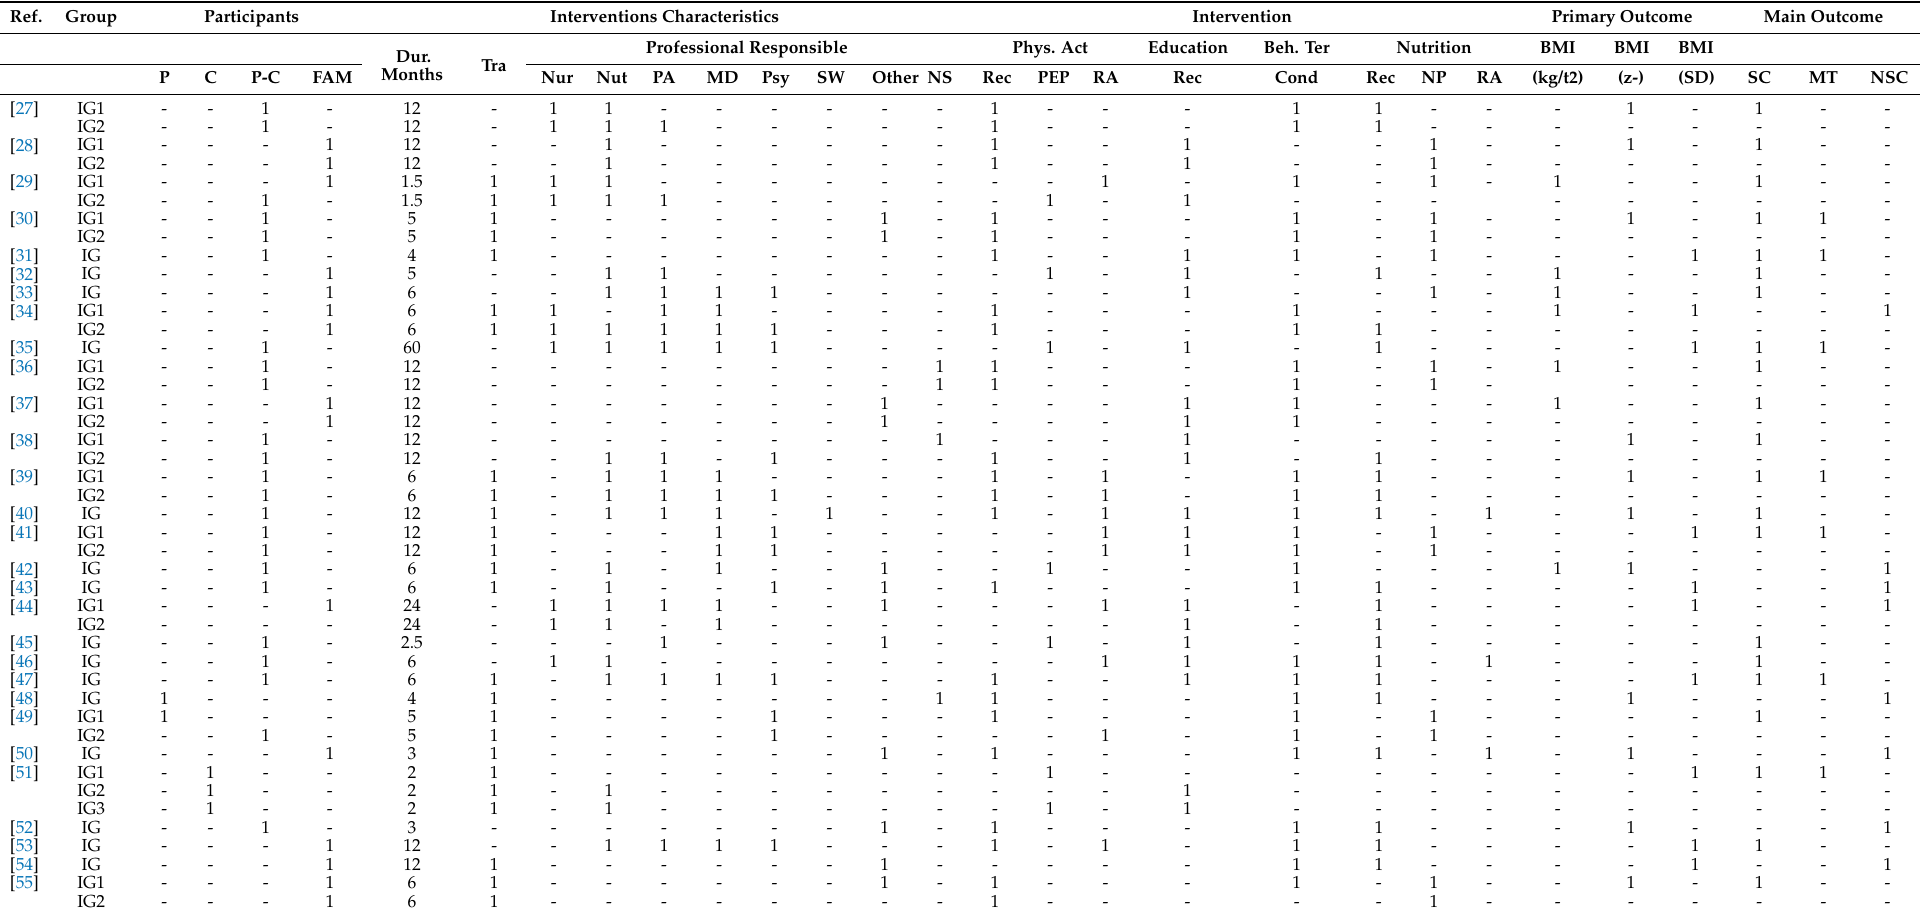
Table 3. Main characteristics of multicomponent interventions according to component